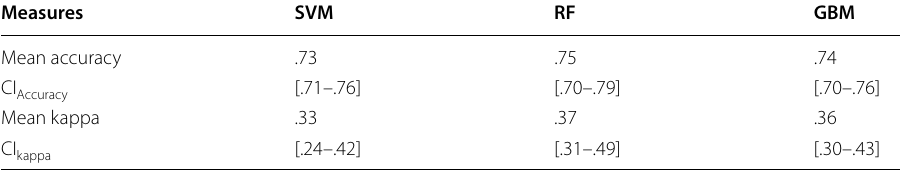
Table 3 Mean Classification Accuracy and Kappa From the Cross-Validation for All